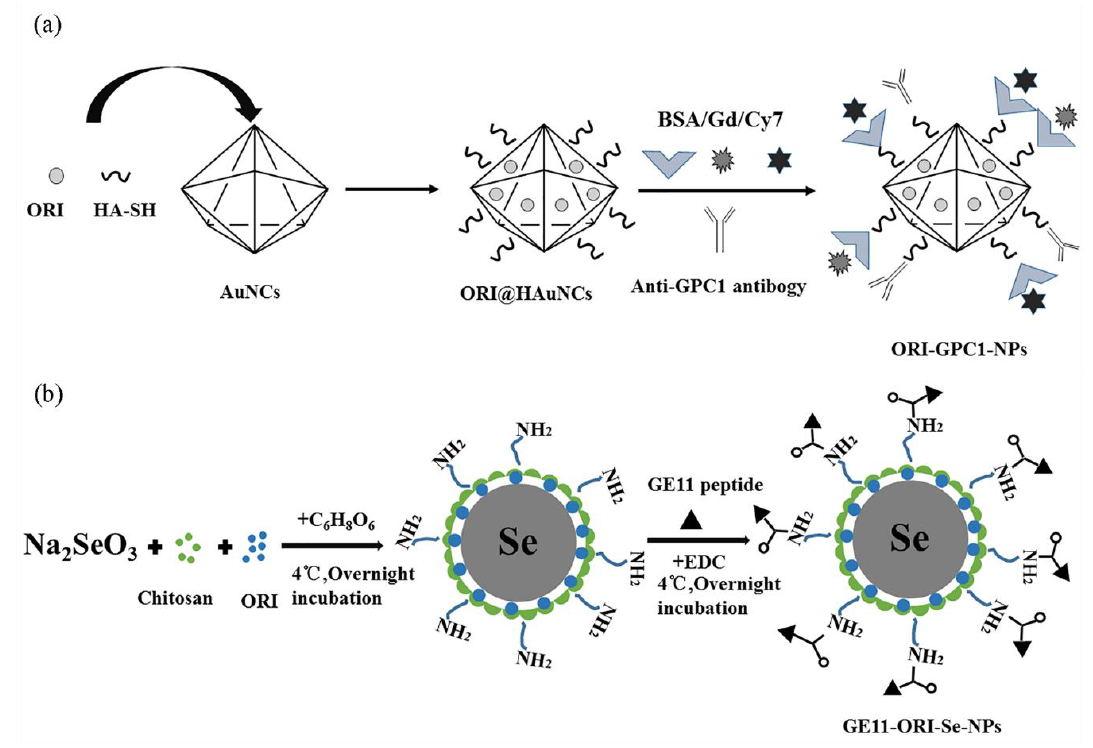
Figure 9. Schematic diagram of preparation of ( a ) ORI-GPC1-NPs. ( b ) GE11-ORI-Se NPs.